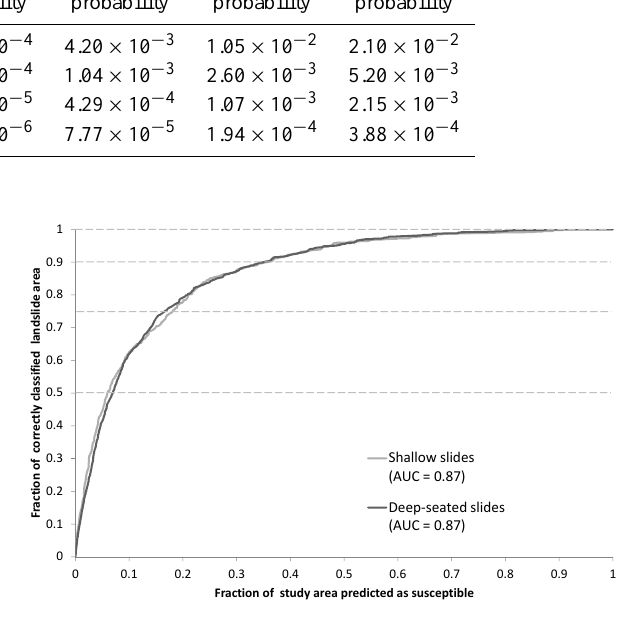
Table 6. Probability of occurrence of superficial landslides in 1, 10, 25, and 50 years in the Loures municipality. Susceptibility Area (no. Predictive of pixels) capacity probability probability probability